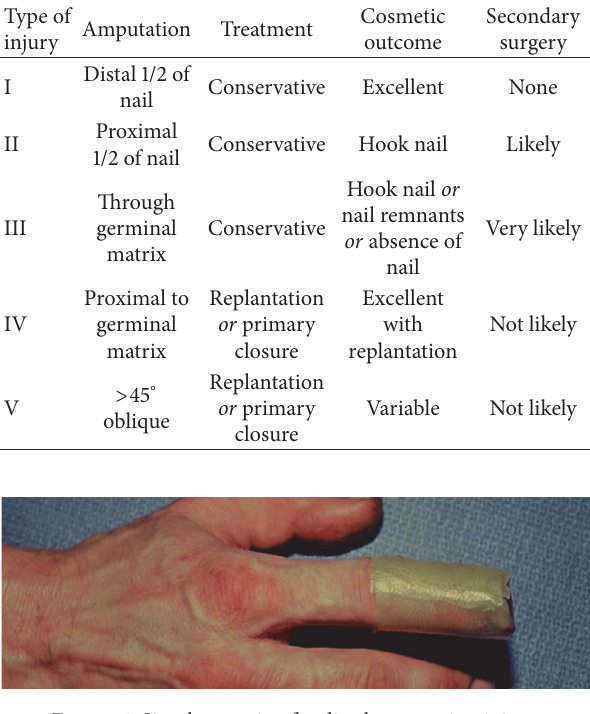
Figure 1: Simple covering for distal amputation